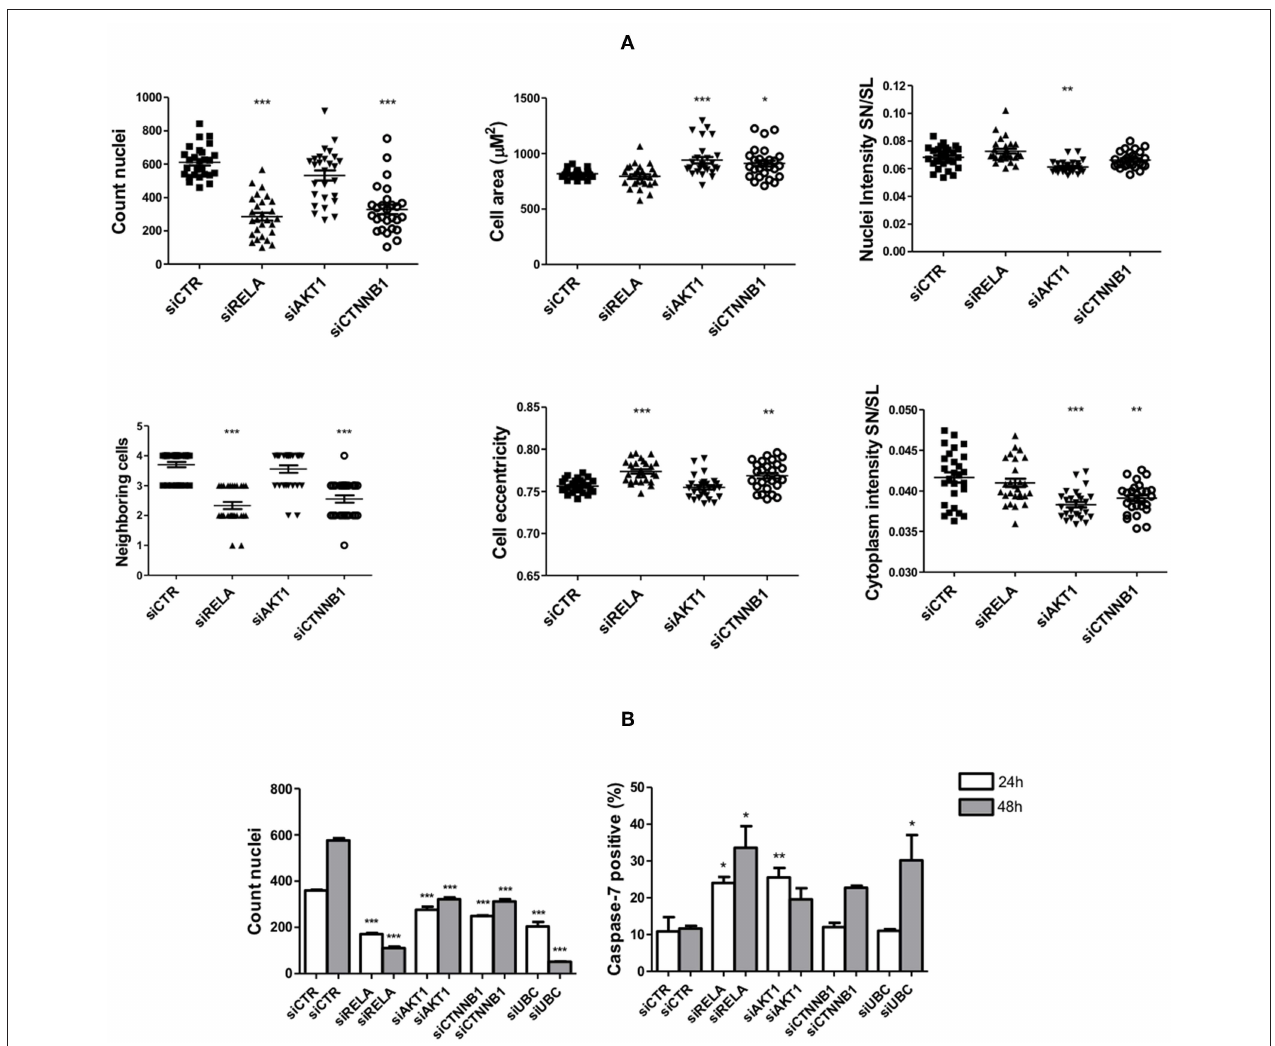
FIGURE 8 | Changes in cell survival and EMT upon interferences in signaling pathways targeted by the anti-survival/EMT group. The FADU cell line was transfected with siRNAs specific for RELA , AKT1 , CTNNB1 , cytotoxic siUBC, and unspecific siRNA control (siCTR), followed or not by TNF- α stimulation. At the endpoint, images were acquired with an ImageXpress Micro XLS HCS system (Molecular Devices), using a 10X objective and excitation/emission filters DAPI (Hoechst), FITC (SN/SL) and Cy5 (CellMask Deep Red). (A) Cells were stimulated for 72h with TNF- α (20ng/mL), starting 24h post-transfection, followed by immunostaining with antibodies against Snail/Slug (SN/SL) and co-staining with nuclear (Hoechst) and cytoplasmic (CellMask) dyes. Alterations in morphometric parameters, cell counts and nuclear/cytoplasmic Snail/Slug due to siRNA transfection as observed after image analysis. (B) 24 and 48h after transfection, cells without TNF- α stimulation were immunostained with antibodies against cleaved Caspase-7 and co-stained with nuclear (Hoechst) and cytoplasmic (CellMask) dyes. Cell counts and percentage of apoptotic cells positive for active caspase-7 as observed after image analysis. Statistically significant differences (ONE-WAY Anova with Tukey post-test), in comparison to the control condition: * p < 0.05; ** p < 0.01; *** p <